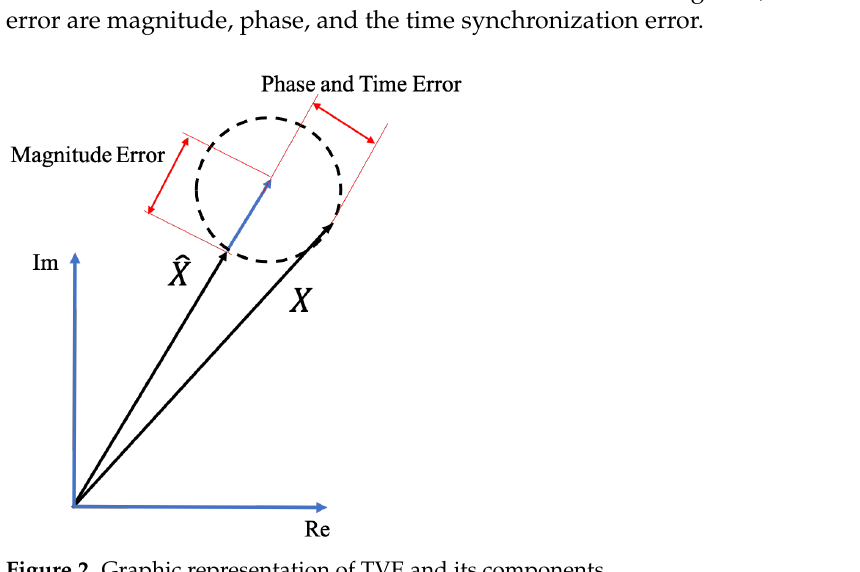
Figure 2. Graphic representation of TVE and its components.